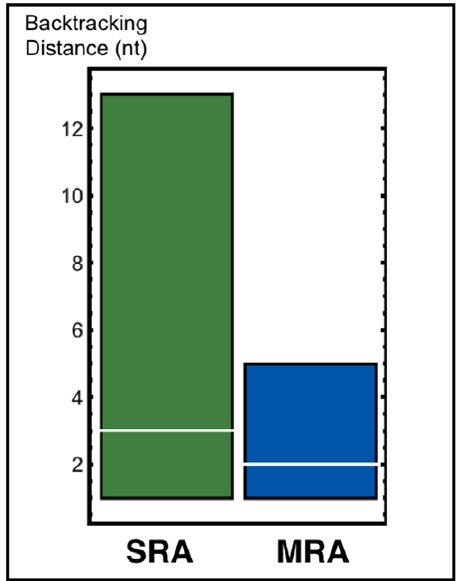
Figure 7. Distribution of the distances covered by backtracked RNAPs from the backtracking site: The lower and upper limits of the boxes correspond respectively to the first and third quartiles. The median is highlighted in white.